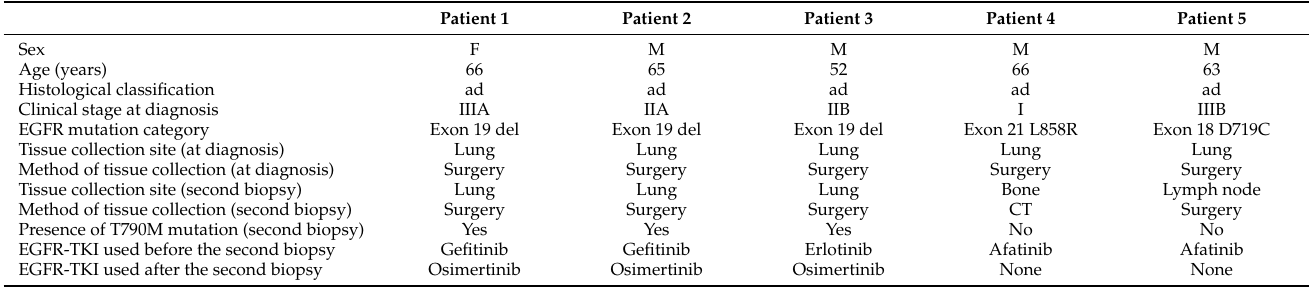
Figure 6. PAI-1 expression in the tumor specimens between pretreatment and time of acquired resistance to EGFR-TKIs. Representative images of tumor specimens stained with an antibody against human PAI-1 via immunohistochemistry: ( A ) at the time before the start of treatment (pretreatment) and ( B ) at the time of acquired resistance to EGFR-TKI (post-treatment). Magnification: × 200. Bar: 100 µm. ( C ) The proportion of PAI-1 positivity is the area between pretreatment and post-treatment. Data represent the mean values of five samples with standard error bars; * p < 0.05 compared with pretreatment (Student’s t -test). Table 1. Clinical characteristics of the five examined